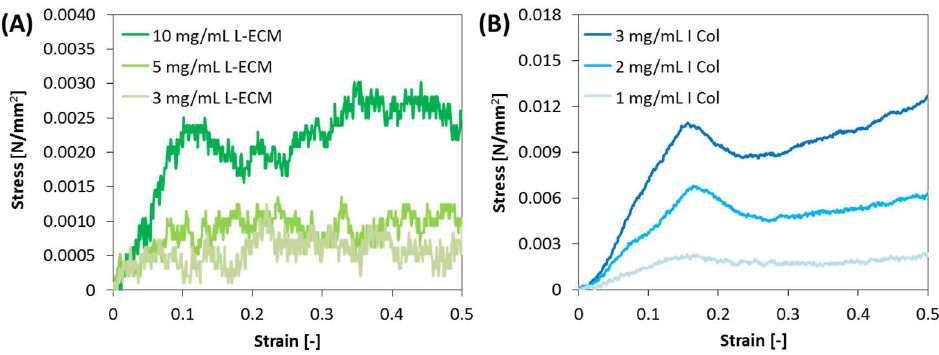
Figure 10. Average stress-strain responses ( n = 3) of ( A ) L-ECM gel, and ( B ) I Col gel.